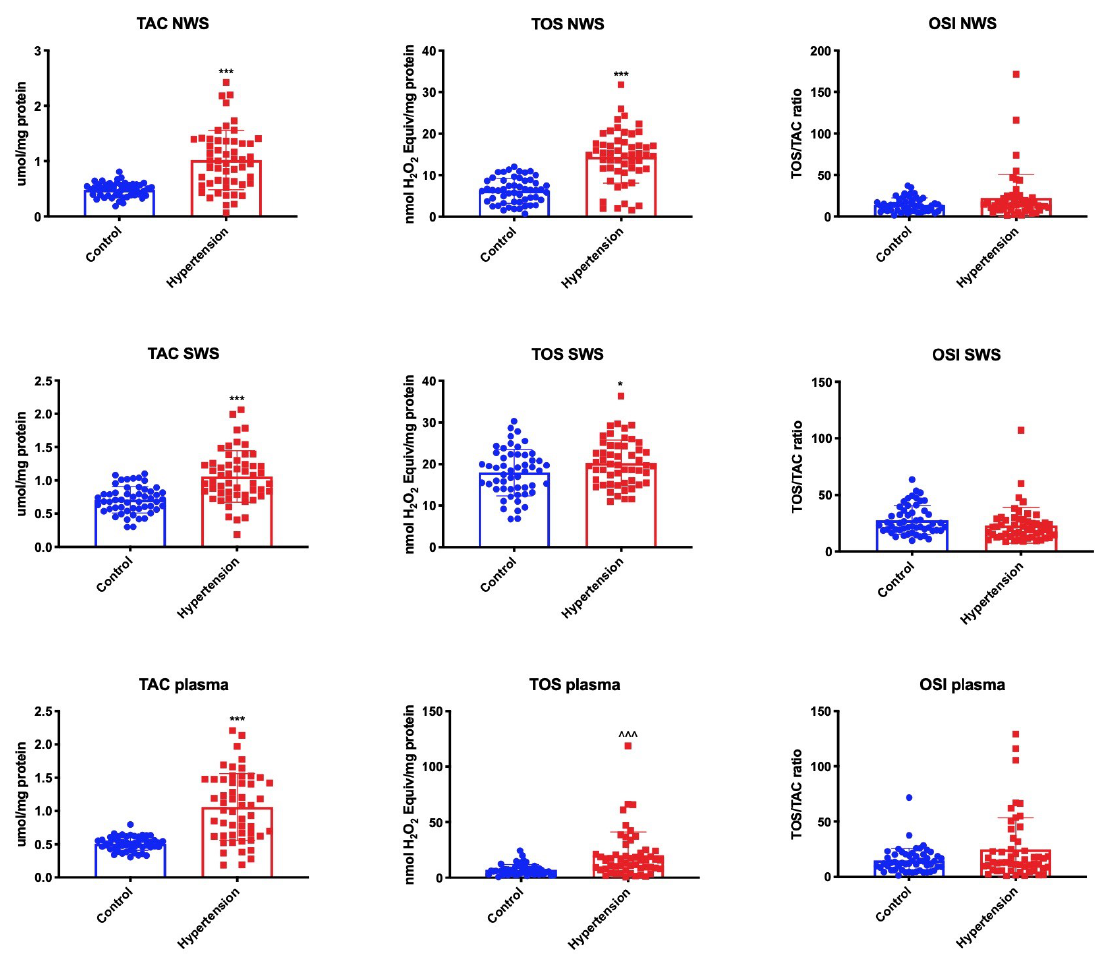
Figure 3. Redox status in children with hypertension and healthy controls. NWS